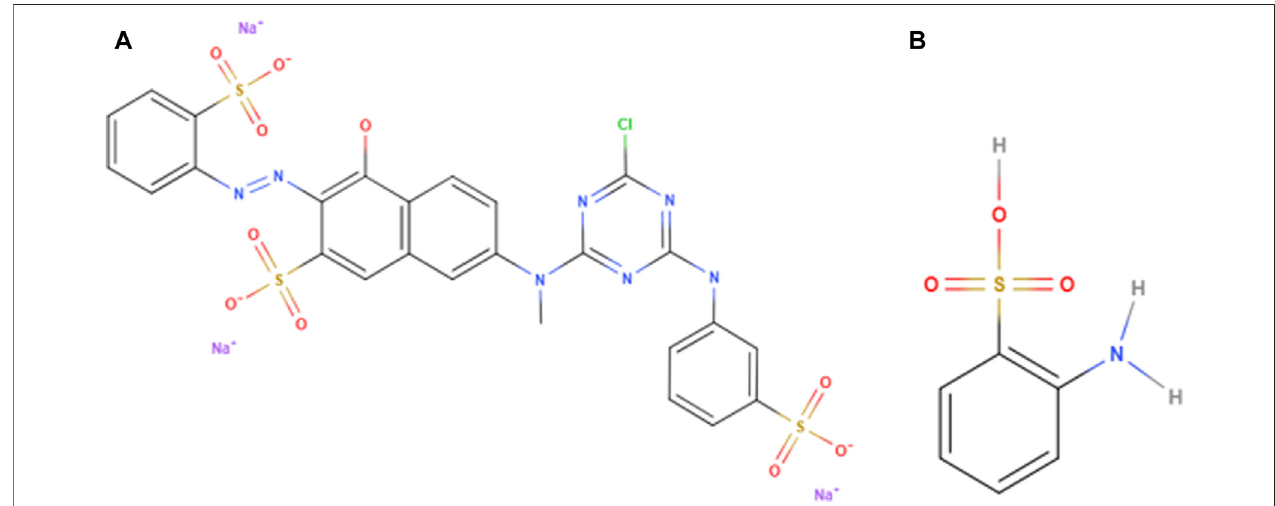
FIGURE 1 | Chemical structures of model pollutant dye. (A) Acidic orange 5 and its degraded product (B) 2-aminobenzenesulfonicacid.